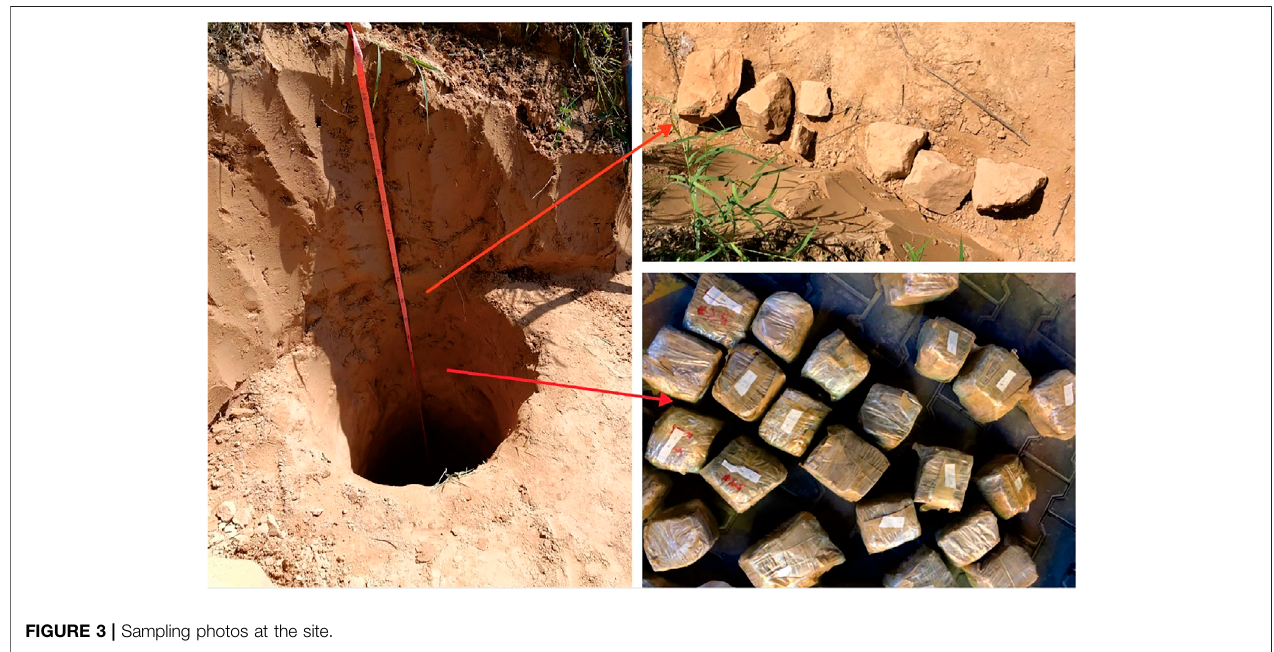
FIGURE 3 | Sampling photos at the site.